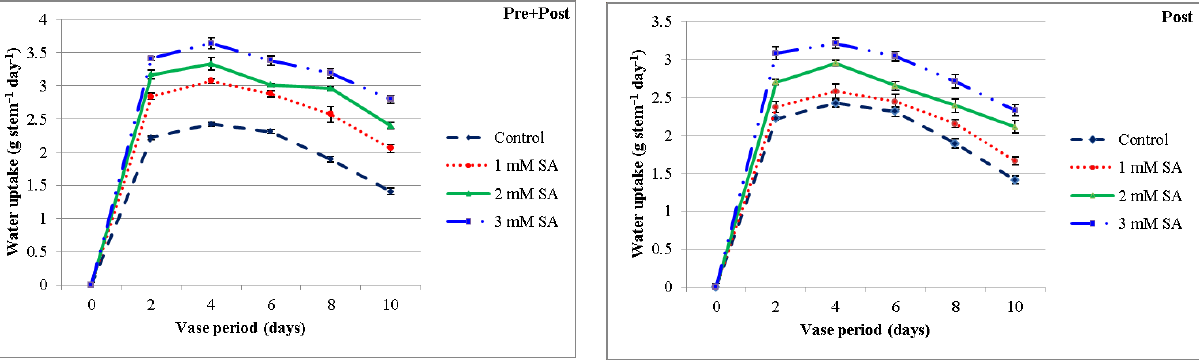
Fig. 2. Effect of pre + post-harvest and post-harvest applications of different concentrations of salicylic acid on water uptake (g stem -1 day -1 ) of cut alstroemeria flowers during vase period. The results represent the means of 12 cut flowers in 4 replicates ± stan- dard